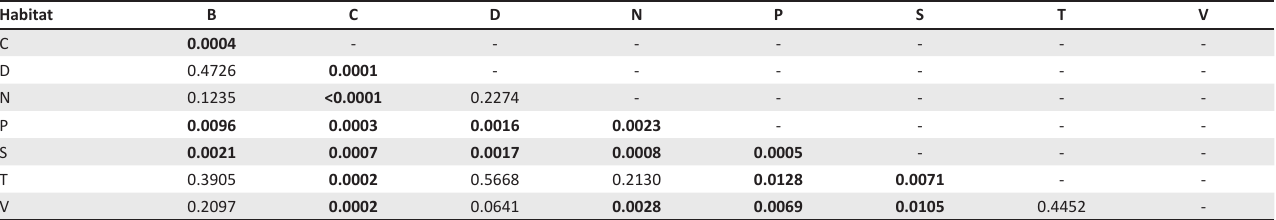
Note: Values in bold indicate significant differences between habitats. Habitat abbreviations: B, Searsia burchellii closed evergreen shrubland; C, cultivated Digitaria eriantha pastures; D, freshwater dam; N, Olea europaea closed evergreen shrubland on northern slopes of hill; P, O. europaea closed evergreen shrubland on plateau of hill; S, O. europaea closed evergreen shrubland on southern slope of hill; T, Tarchonanthus camphoratus closed evergreen shrubland; V, Vachellia karroo open deciduous shrubland.